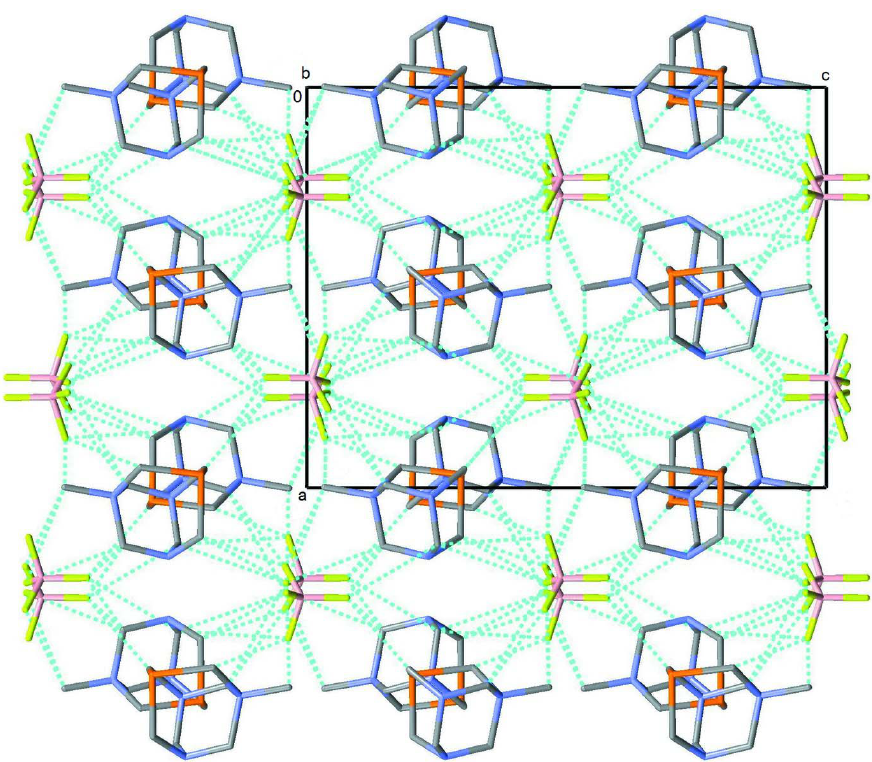
Partial representation (view along the b axis) of the crystal packing diagram of (I) showing the generation of the three- dimensional supramolecular assembly via C—H···F hydrogen bonds and C···F short contacts (blue dotted lines). Hydrogen atoms and disordered F1B and F3B atoms are omitted for clarity. C, grey; N, blue; P, orange; F, light green; B,